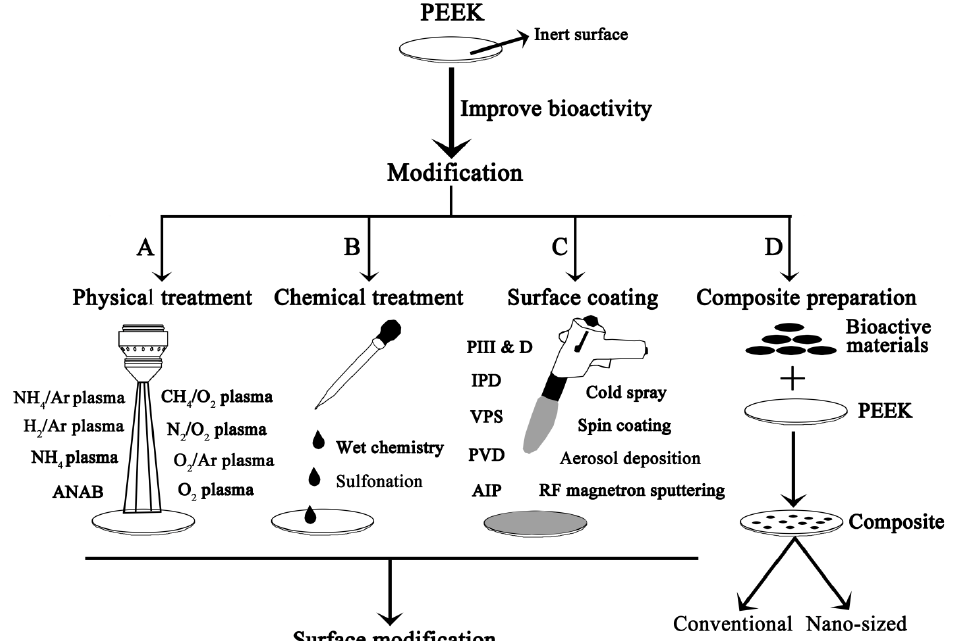
Figure 1. Scheme of current strategies to improve the bioactivity of